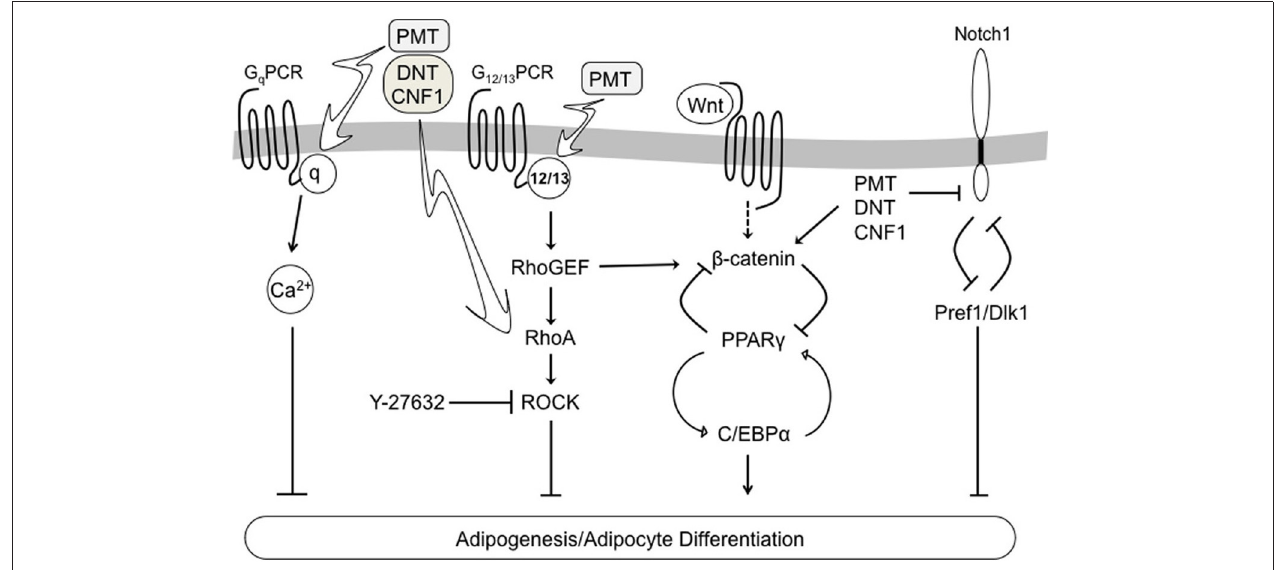
FIGURE 6 | Schematic diagram depicting a proposed model of dermonecrotic toxin action on multiple signaling pathways involved in regulating 3T3-L1 adipocyte differentiation and adipogenesis.